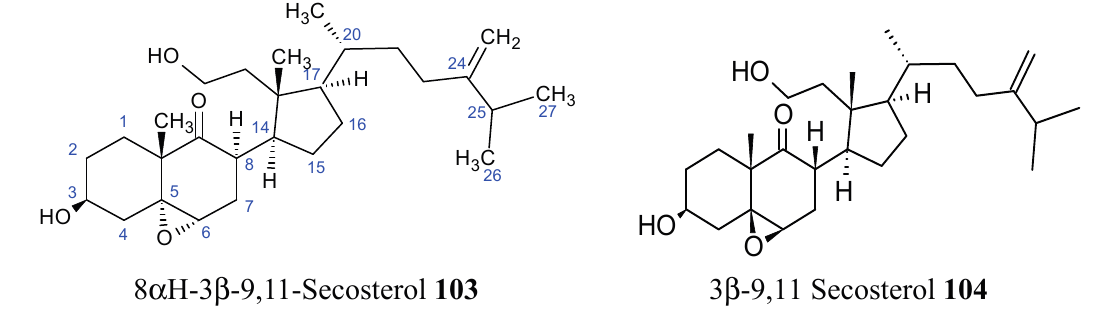
Figure 35. Secosterol analogs 103 , 104